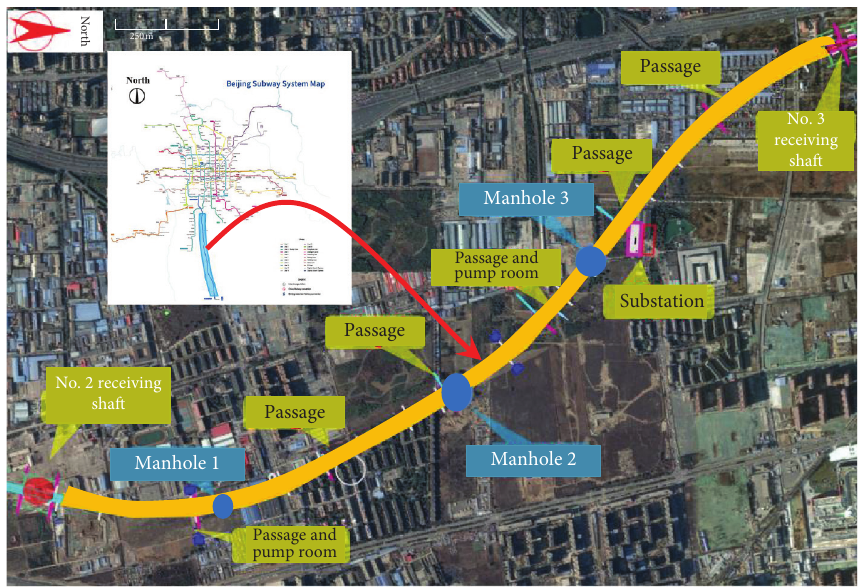
Figure 1: Location of the studied tunnel.